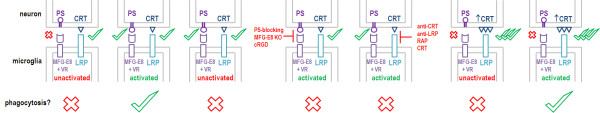
Schematic representing requirements for primary phagocytosis of neurons to proceed. Primary phagocytosis of viable neurons does not proceed without microglial activation. Basal levels of surface-exposed CRT are not sufficient alone to allow phagocytosis, but CRT-dependent phagocytosis can be triggered by an increase in either PS or CRT exposure. CRT, calreticulin; PS, phosphatidylserine.